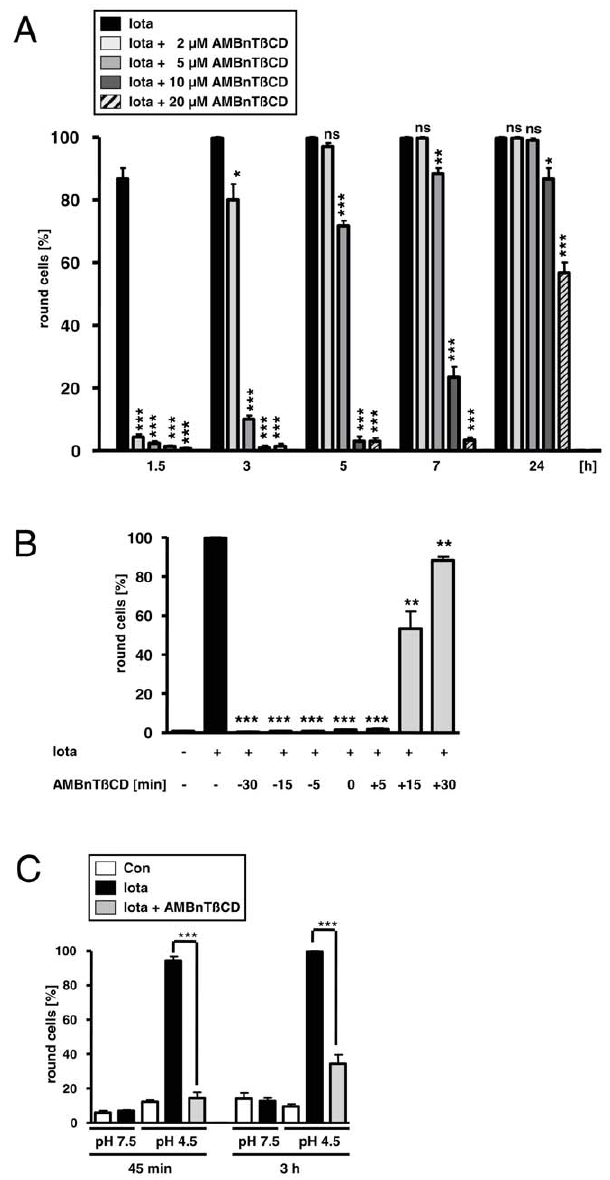
Figure 7. AMBnTßCD protects Vero cells from intoxication with iota toxin from C.perfringens and inhibits the pH-dependent membrane translocation of the toxin. A . Time- and concentration- dependent inhibition of the intoxication of Vero cells with iota toxin. Vero cells grown in 24-well dishes to subconfluency were treated for 30 min at 37 u C with 2, 5, 10 and 20 m M final concentrations of AMBnTßCD or without AMBnTßCD for control. Iota toxin (200 ng/ml Ib + 100 ng/ml Ia) was added and cells were further incubated at 37 u C with the toxin in the absence or presence of AMBnTßCD. Pictures were taken after the indicated incubation periods, the number of total cells and round cells were counted and the percentages of round cells calculated. Values are given as mean 6 S.D. (n=3) and significance was tested for each time point between iota toxin-treated samples without and with the respective concentration of AMBnTßCD by using the student’s t-test (***p , 0.0005; *** , 0.005; * , 0.05). B . The time point of AMBnTßCD application determines the protective effect against iota toxin. AMBnTßCD (10 m M) was applied to Vero cells at 30, 15 or 5 min before iota toxin (200 ng/ml Ib + 100 ng/ml Ia), together with iota toxin or 5, 15 or 30 min after the toxin. As a control, cells were treated with medium or with iota toxin alone. The cells were incubated for 3 h at 37 u C and pictures were taken to determine the percentages of